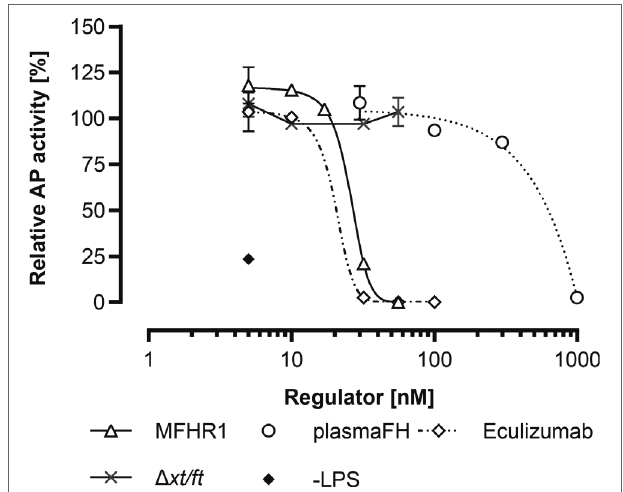
FIGURE 7 | MossMFHR1 inhibits the AP activity after induction of the alternative pathway in human serum. The C5b-9 complex formation was measured by ELISA after LPS-induced AP activation. Data represent mean values and bars show the range of duplicates and were analyzed with two- way ANOVA followed by Bonferroni test. The serum without regulators was set to 100% and heat-inactivated serum to 0%. Activity in wells not coated with LPS (-LPS) was used as a reference. Purified extract of the parental moss strain Δ xt/ft was included as a negative control, in equal amounts to the volume of MFHR1 used. Analyses were done with GraphPad Prism software version 8.0 for